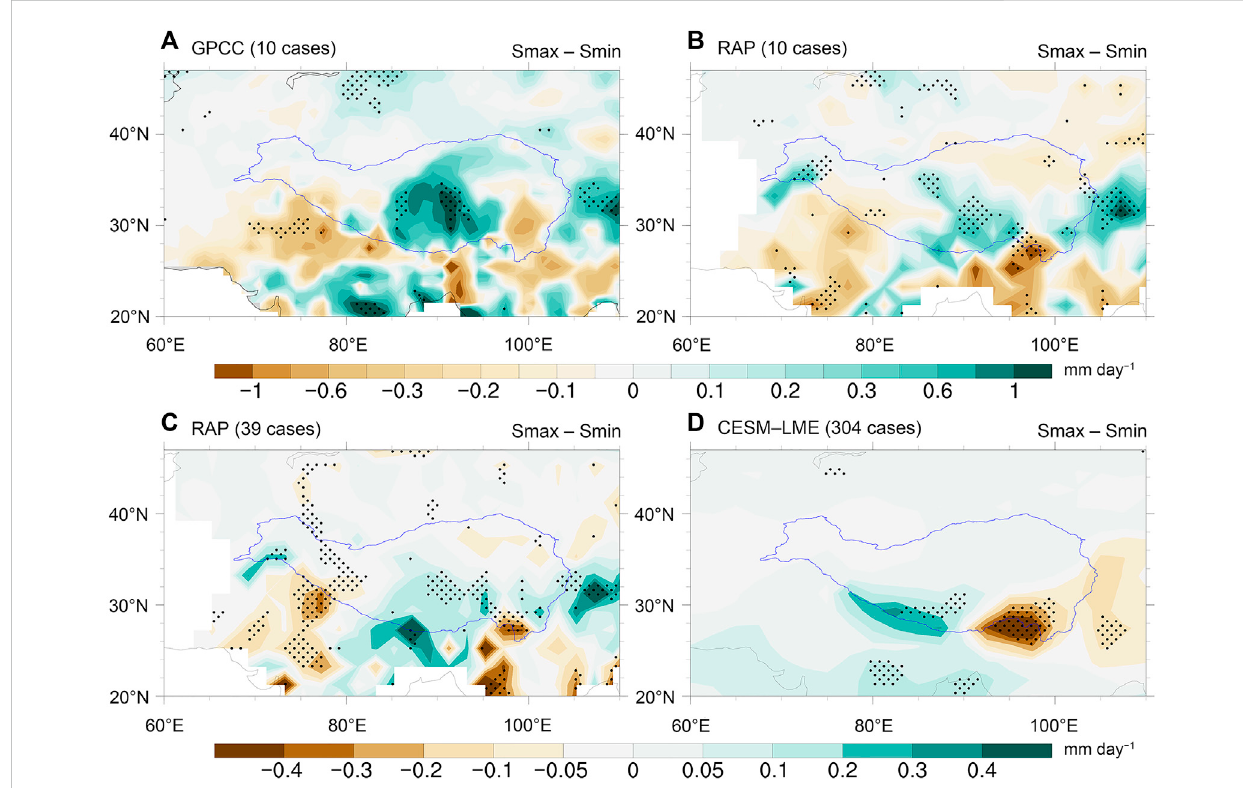
FIGURE 2 Composite differences in JJA mean precipitation (mm day − 1 ) between the 11-year solar maximum (Smax) and minimum (Smin) phases. (A) Results from the GPCC during 1901 – 2013 (10 cases). (B) Results from the RAP reconstruction during 1901 – 2013 (10 cases). (C) Results from the RAP during 1470 – 2013 (39 cases). (D) Ensemble-mean result of four TSI experiments (304 cases). The black dots denote signi fi cance at the 90% con fi dence level (two-tailed Student ’ s t -test). The solid blue lines denote the elevation contour of 2,000